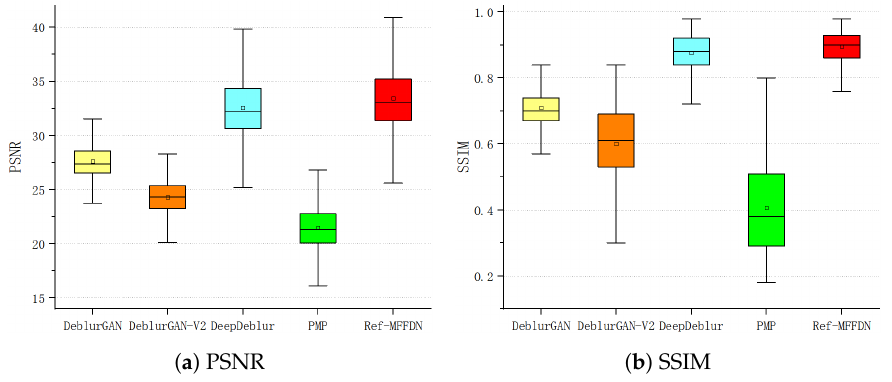
Figure 7. The distribution of PSNR and SSIM of different deblurring methods on the testing set. The box plot displays the maximum, upper quartile, median, lower quartile, and minimum of results from top to bottom. The rectangle inside the box represents the average metrics of